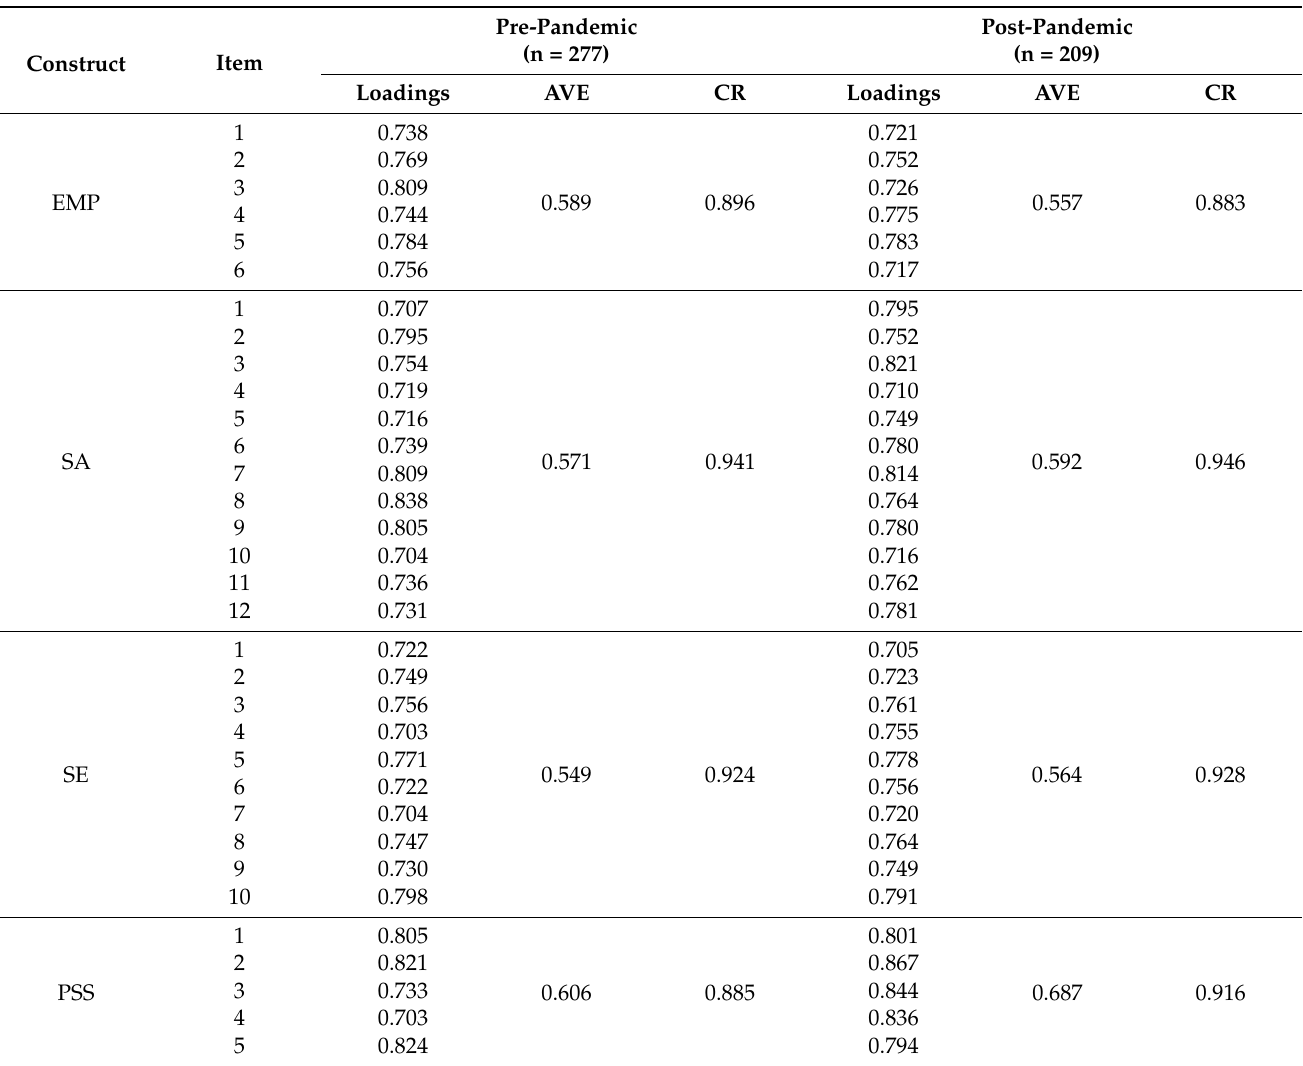
Table 5. Reflective measurement